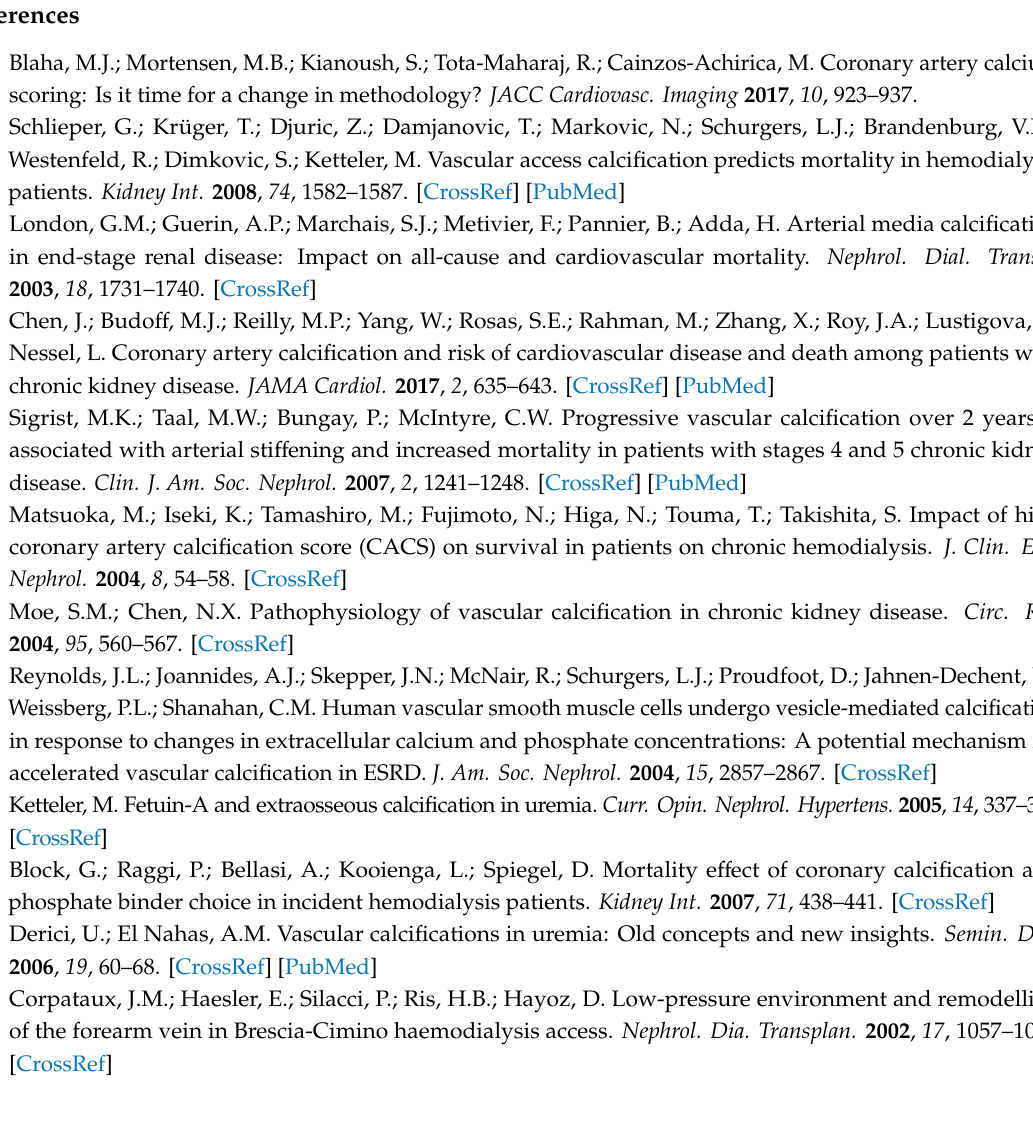
Figure S1: Flow chart of the subjects, Figure S2: The distribution of magnesium in our